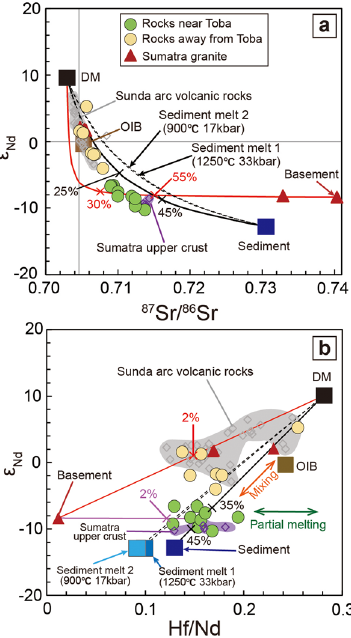
Fig. 5 Mixing diagrams between the mantle, subducted sediments, and basement rocks of Sumatra. a ε Nd versus 87 Sr/ 86 Sr diagram showing that rocks near Toba can be produced by mixing of DM (represented by N-MORB 86 ) with 25 to 45% sediments or sediment melts. Deviation of 87 Sr/ 86 Sr and ε Nd of rocks near Toba from the modeling trends between DM and sediment melts can be explained by early extraction of Sr from the sediments by dehydration fl uids. Rocks away from Toba, however, have ε Nd and 87 Sr/ 86 Sr compositions that can be explained by either crustal contamination or sediment addition. Compositions of the Sumatran basements are represented by the most isotopically-enriched S-type granites on Sumatra 18 . Compositions of the previously reported Sunda arc volcanic rocks 17,39,40 , which belongs to rocks away from Toba, are also plotted in the gray fi eld. Details for the end-member compositions can be found in Supplementary Data 5. b ε Nd versus Hf/Nd diagram indicating that rocks near Toba were probably produced by mixing of DM with 35 to 45% sediment (melts) followed by partial melting, whereas rocks away from Toba are consistent with mixing of DM with minor (<3%) Sumatra basement melts 14